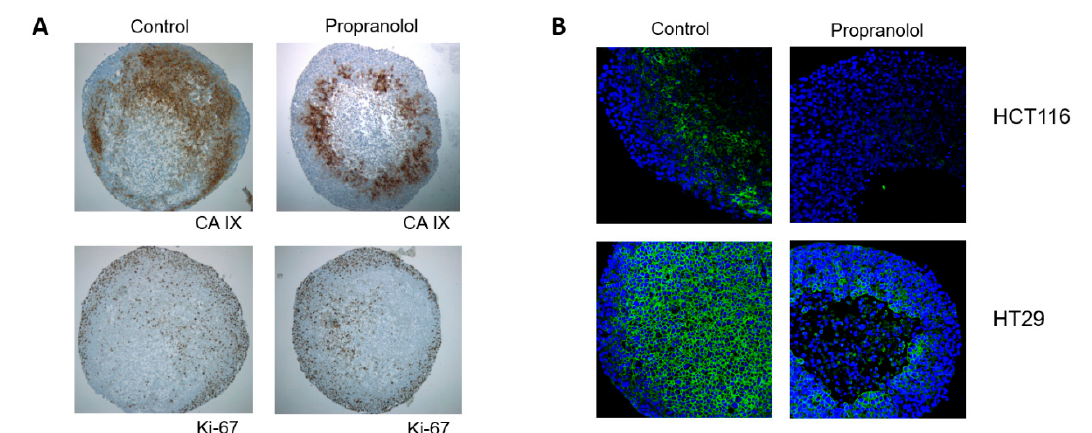
Figure 5. Propranolol influences adaptation of cells to hypoxic microenvironment and decreases level of CA IX. ( A ) Immunohistochemical analysis of CA IX and Ki-67 expression and localization in HCT116 spheroids sections. CA IX was expressed in the hypoxic centre and perinecrotic regions, a strong expression was observed in the regions very close to the spheroid surface. Expression of CA IX was detected in areas of proliferative Ki-67 positive cells. Localization and distribution of CA IX in spheroids is, independently of propranolol treatment, polarized and non-uniform. Proliferative (Ki-67 positive) and CA IX positive cells are localized in the field opposite to necrotic cells area. ( B ) Immunofluorescent analysis of CA IX expression in HCT116 and HT29 spheroids. Reduced expression of CA IX was confirmed also by immunofluorescence. The central regions of the HCT116 and HT29 spheroid were necrotic after 5 days of β -AR inhibition, while the integrity of the control spheroids remained intact.